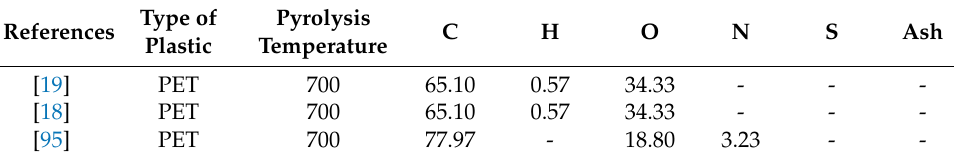
Table 7. Elemental composition of chars derived from plastic